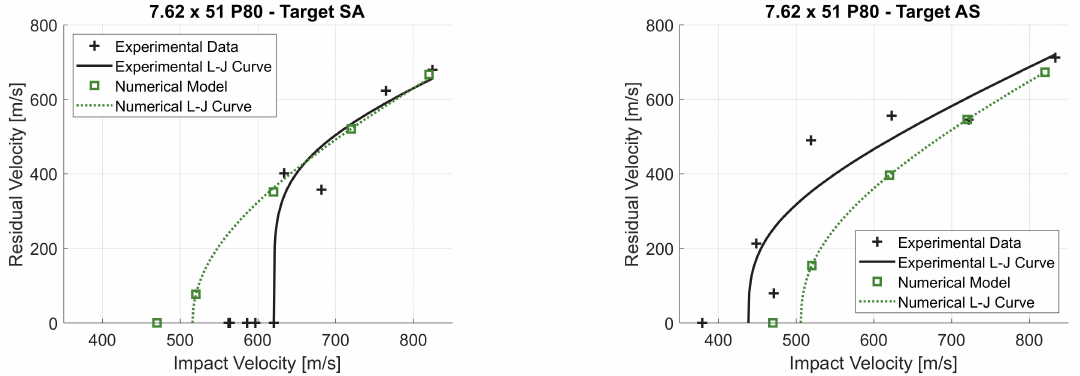
Figure 12. Experimental and numerical ballistic curve for target SA ( a ) and AS ( b